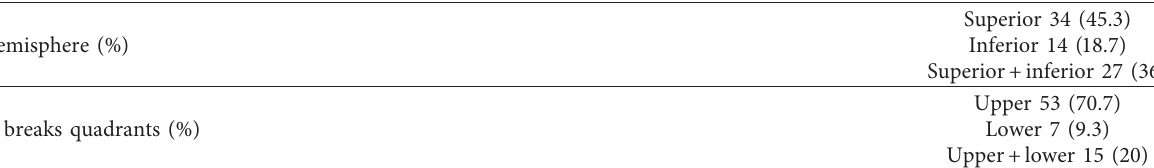
Table 2: Locations of RRD and retinal breaks (75